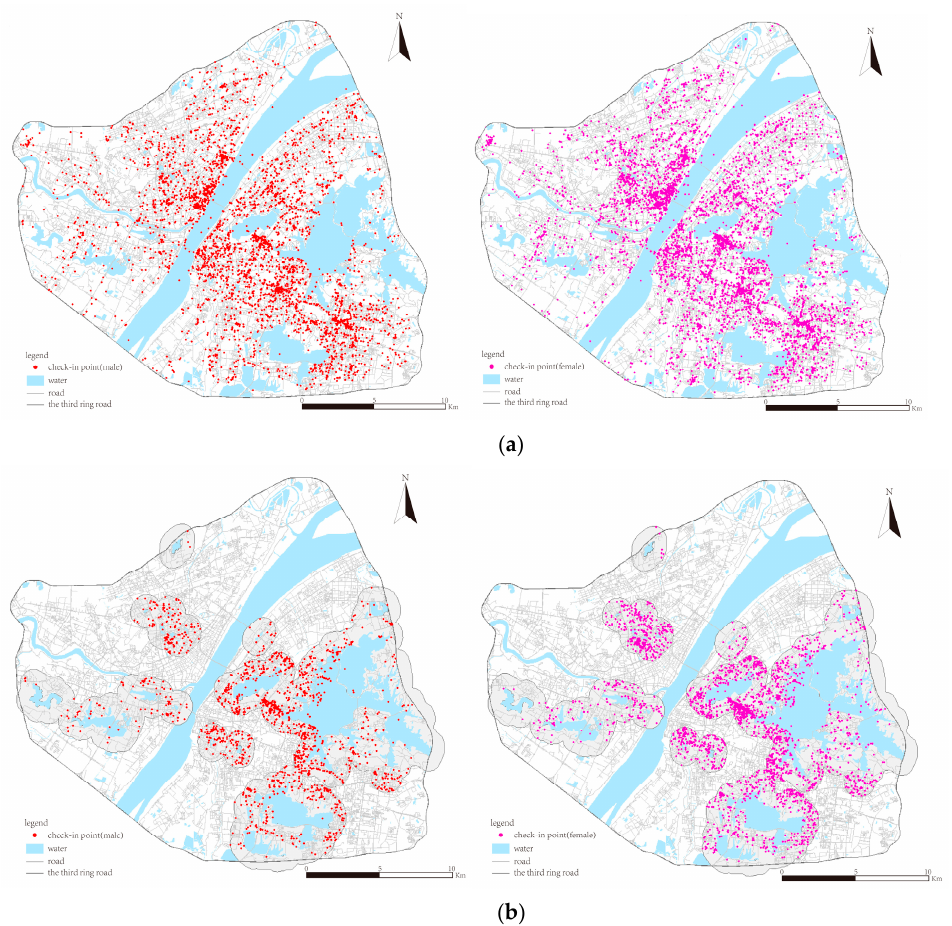
Figure 3. Visualization results of the Weibo data: ( a ) Distribution of check-in points of Weibo users with different genders within the Third Ring Road; ( b ) distribution of check-in points of Weibo users with different genders in the buffer.